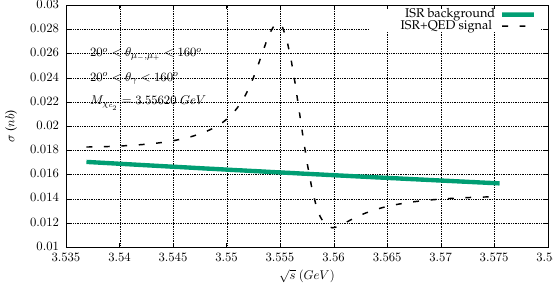
µ + µ − γ in the χ 1 - region. →